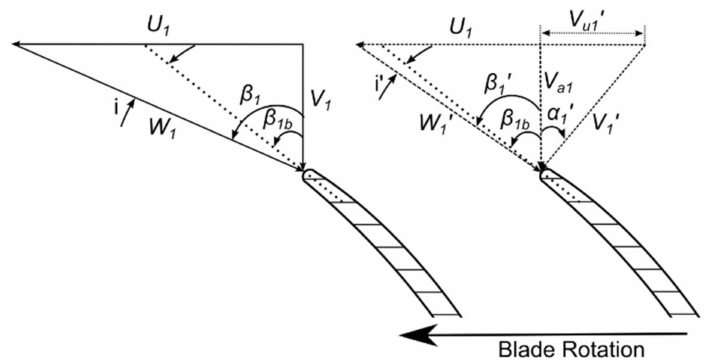
Figure 1. Inlet velocity triangles exhibiting zero and positive